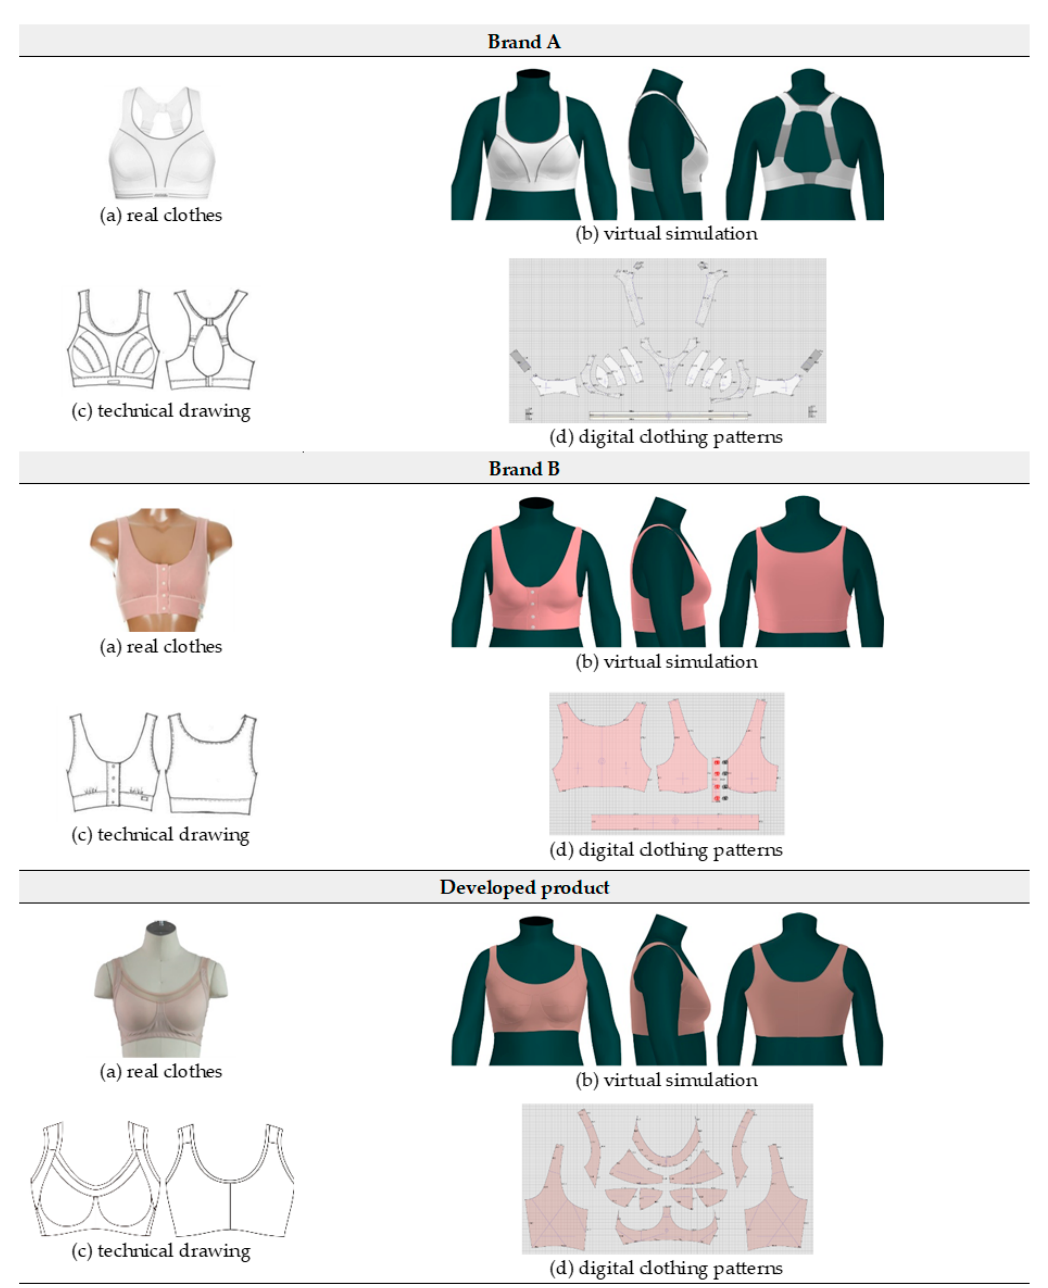
Figure 6. Results of virtual clothing simulation for virtual fitting.